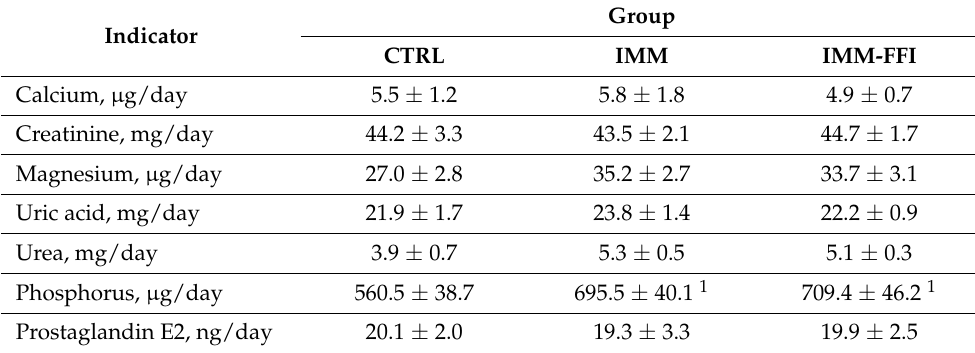
Table 4. Biochemical parameters of urine.